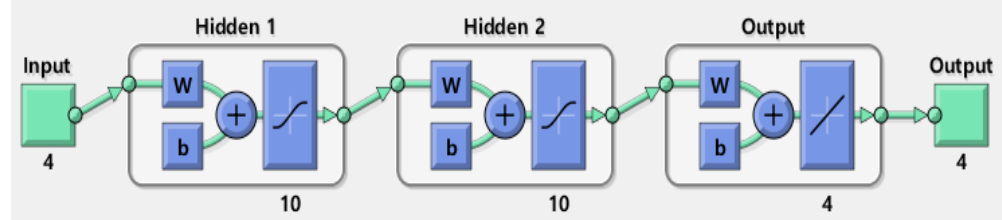
Figure 15. Composition of the artificial neural network model [20]. Table 6. Accuracy of the ANN 1 depending on the number of hidden layers and neurons. Hidden Layer